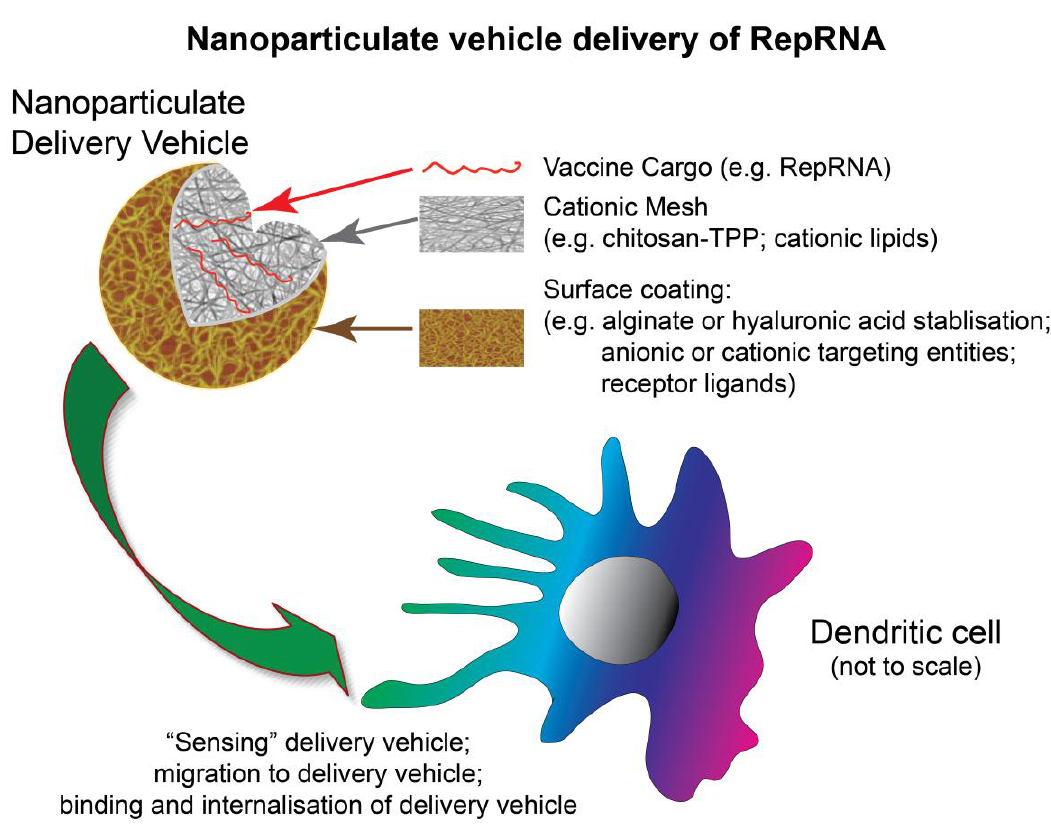
Figure 1. Delivery of RepRNA to DCs by nanoparticulate delivery vehicles. The delivery vehicles can be composed of polysaccharides, lipids, lipoproteins or combinations